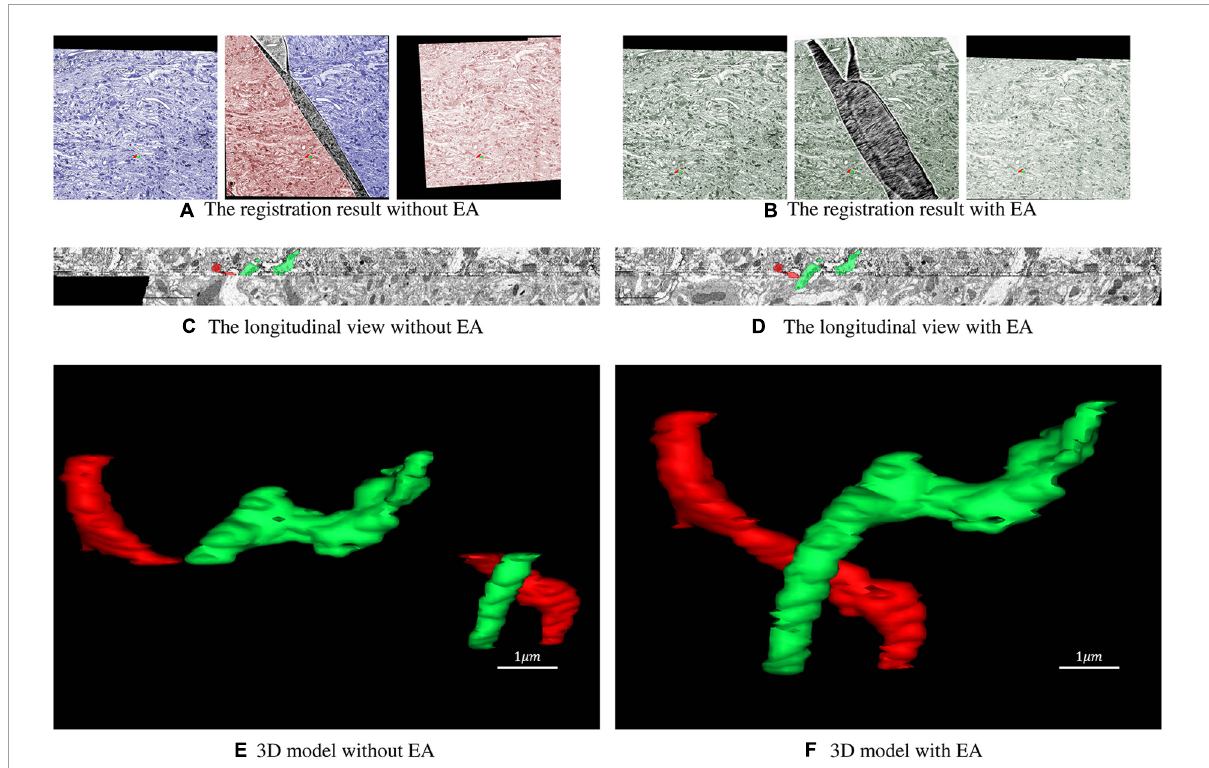
FIGURE6 Registration result of serial sections. (A) The registration result of the folded section with its previous and subsequent sections without the expected affine. The blue part of the folded section represents the area corresponding to the section of the previous layer, and the red part represents the area corresponding to the section of the next layer. (B) The registration result of the folded section with its previous and subsequent sections with expected affine. The green area of the folded section corresponds to the previous and next sections. (C,D) Longitudinal view of the registration result. (E,F) 3D model reconstructed from the registration